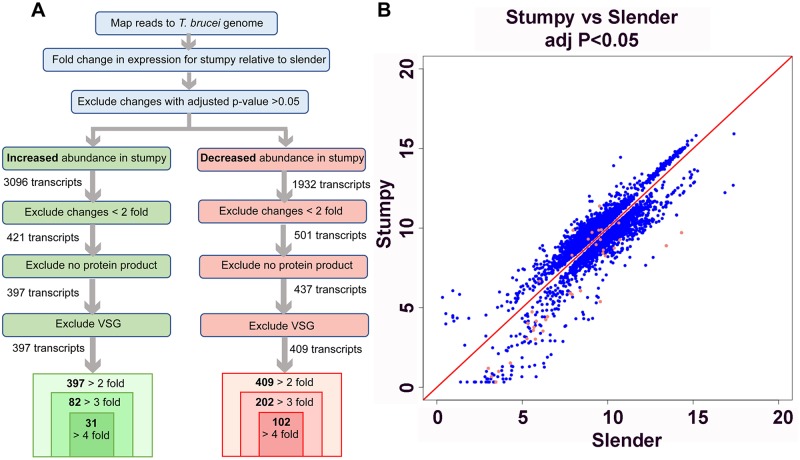
Expression differences between slender and stumpy form T. brucei.(A.)Strategy for the comparison of mRNA expression between slender and stumpy form T. brucei. (B.)Scatterplot showing transcripts that show significant (adjusted p value <0.05) expression difference between slender and stumpy samples. Transcripts annotated as VSG are coloured red.